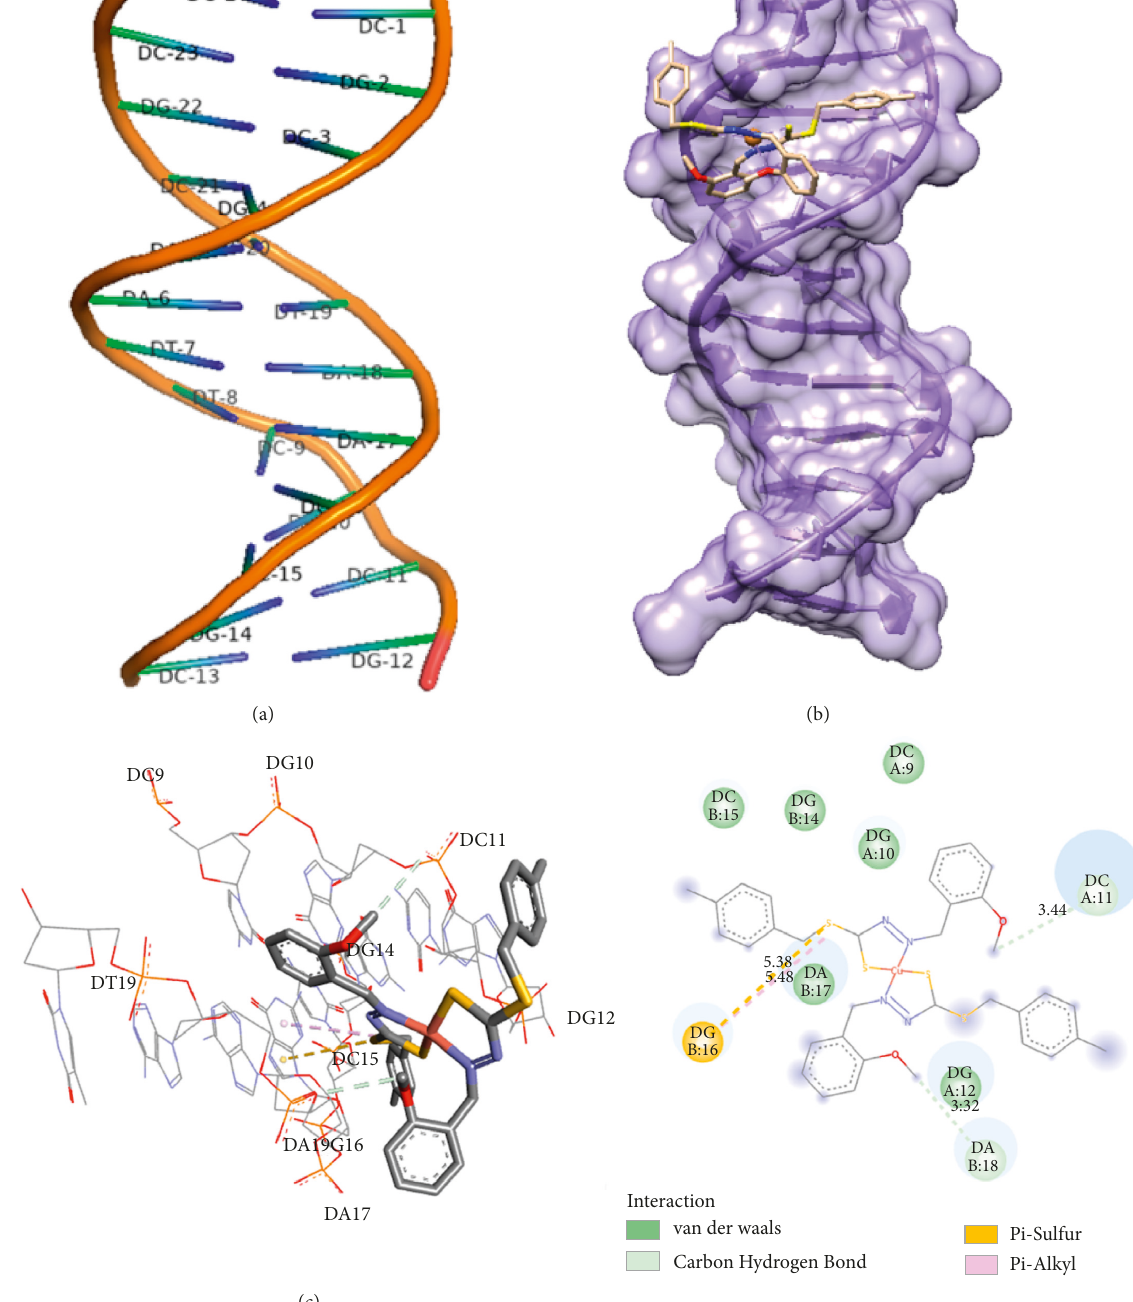
Figure 8: (a) DNA duplex of sequence (PDB ID:1BNA) with labels. (b) The lowest binding energy conformation between 2 with DNA. (c) Molecular docked model showing the interactions of 2 with